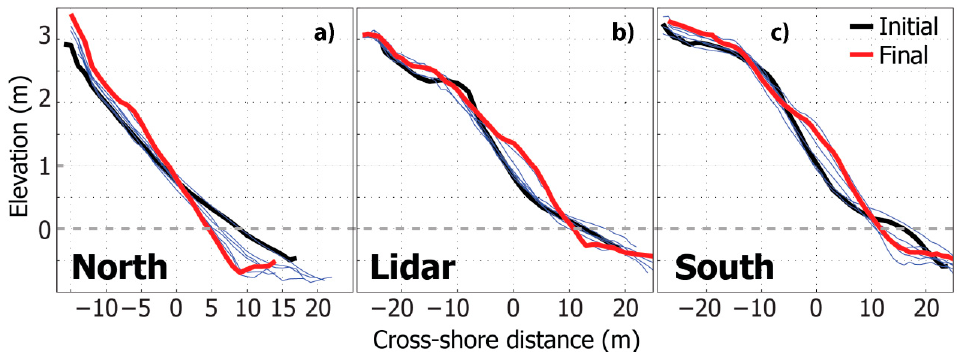
Figure 8. Daily low tide cross-shore beach profiles measured at ( a ) the North, ( b ) LIDAR and ( c ) South transects, the locations of which are shown in Figure 2 .